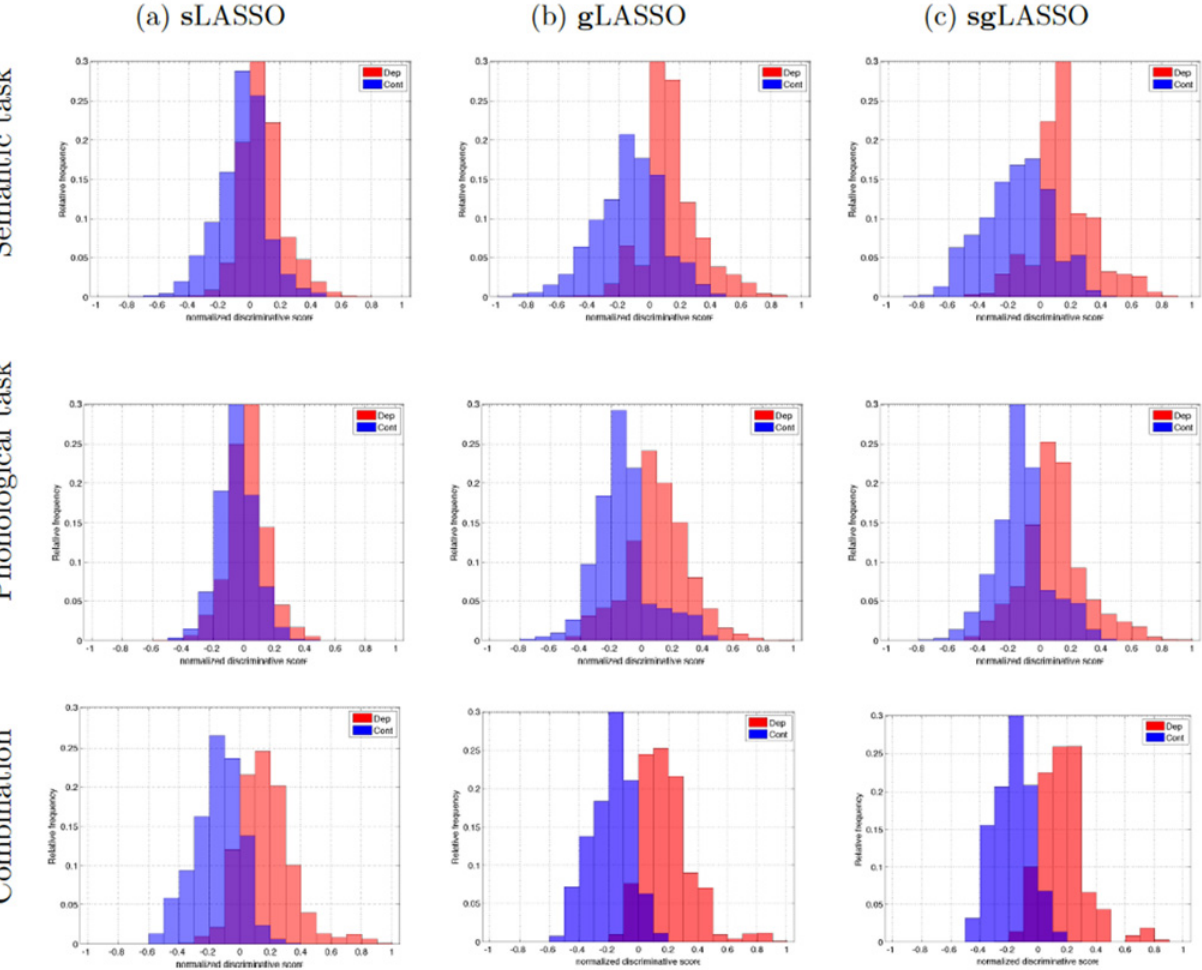
Fig 6. For all algorithms the separation of class probability distributions became clearer when semantic and phonological data were combined. normalized discriminative score distribution was evaluated over all 1000 test datasets produced during the nested cross validation. The discriminative score is given by the logarithmic odds ratio and is here normalized by the maximum value of all test data.